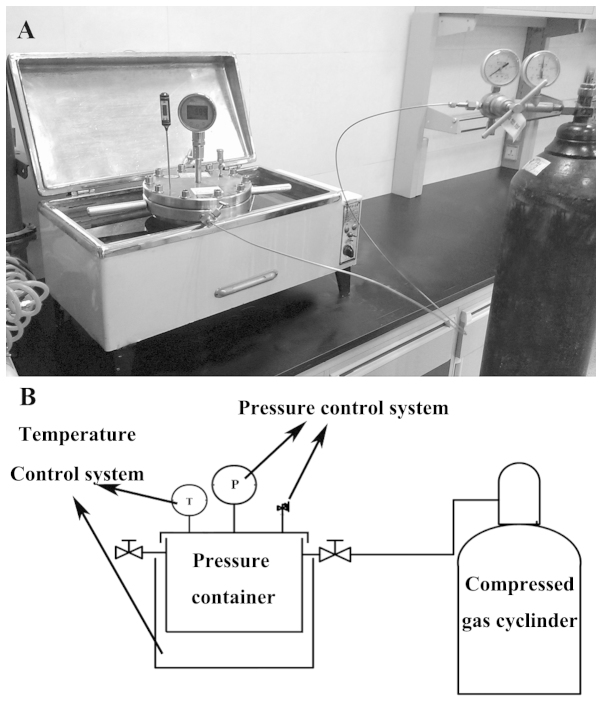
The device for applying pressure to cells. (A) The mechanical pressure-controlled cellular injury unit chart. (B) Schematic diagram of the custom-made instrument for applying mechanical pressure to chondrocytes. The main components of the instrument include a mechanical pressure container, a pressure control system, a temperature control system and a compressed gas cylinder.